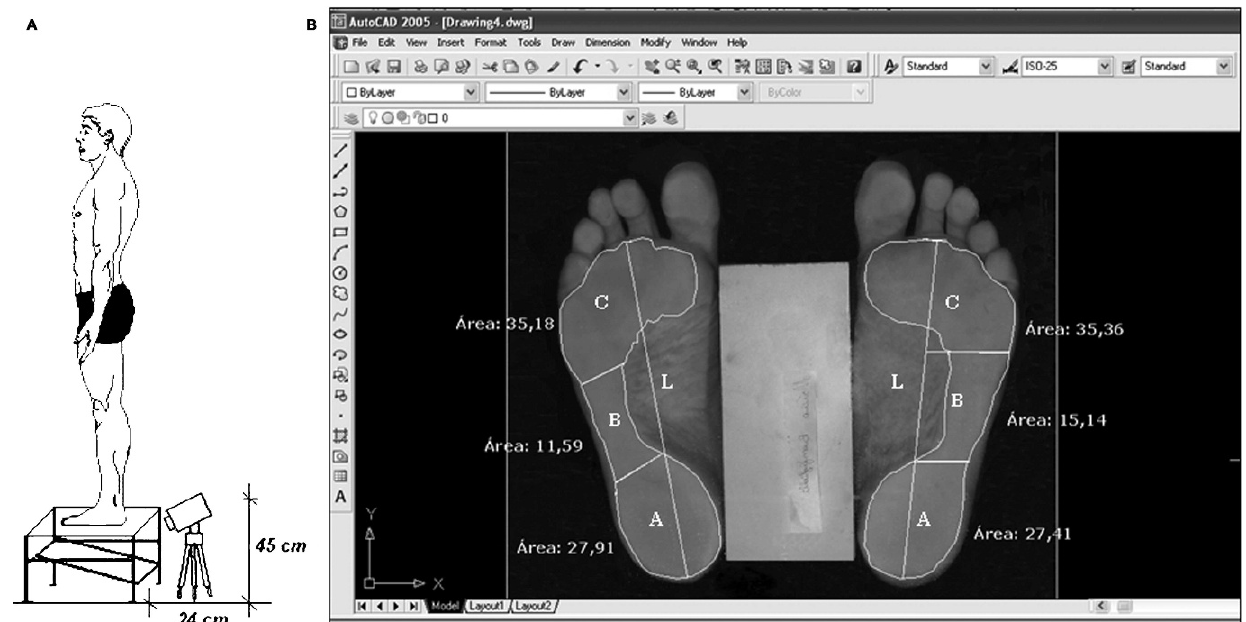
Figure 2 - Positioning of the subject on the podoscope (A). Description of the calculation of the medial longitudinal arch index. L: vertical straight line, A: rearfoot area, B: midfoot area. C: forefoot area (B).